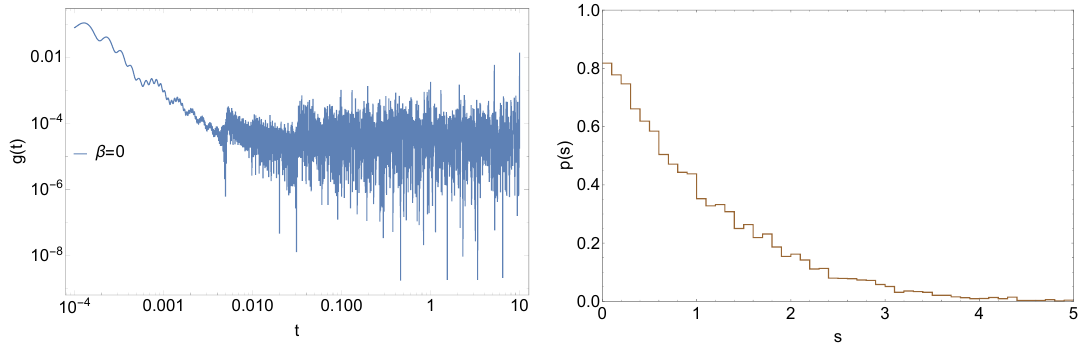
Figure 16. SFF and level spacing plot for rectangular billiard with α 1 = 1 , α 2 = 2 π , n 1 cut = n 2 cut = 100